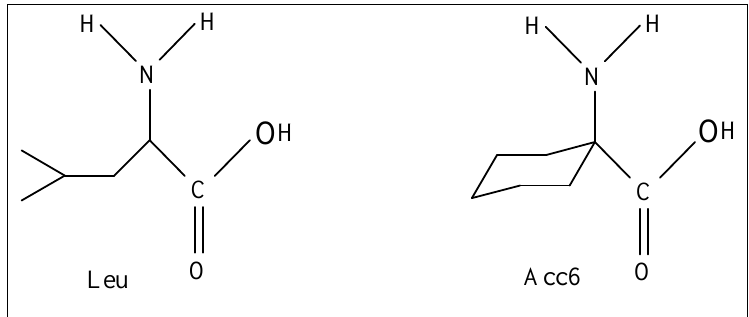
Figure 1. Structures of amino acids Leu and